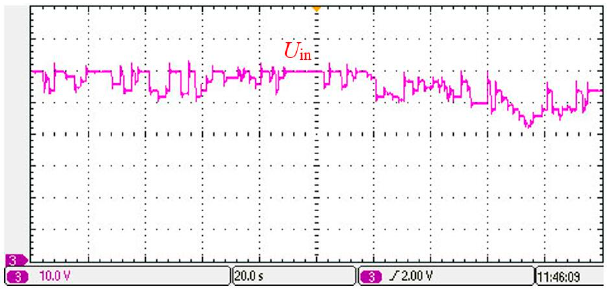
Figure 19. The fuel cell output voltage under the WLTP obtained by using a programmable power supply. The load current waveform is shown in Figure 20 and changes with the load demand power.